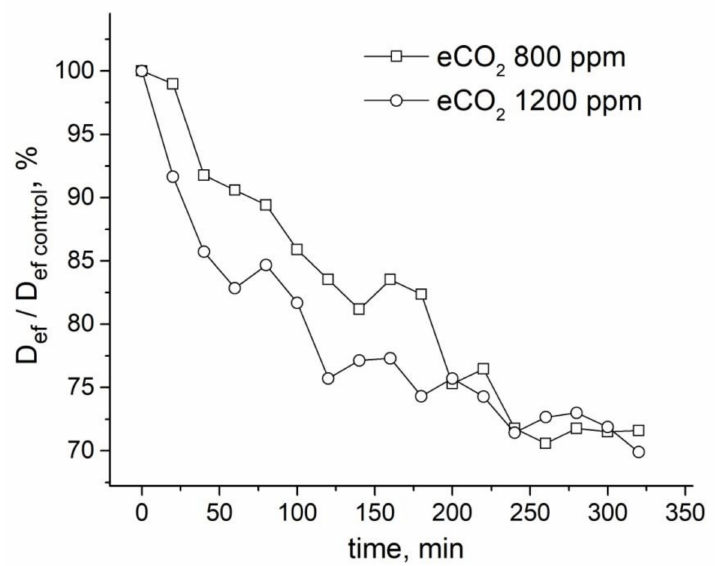
Figure 22. Time dependence of the ratio of effective self-diffusion coefficient ( D ef ) in maize roots under impact of different concentrations of CO 2 to the control value of D ef ( D ef control before CO 2 enrichment): Open squares—dynamics of D ef / D ef control under impact of CO 2 800 ppm; open circles— dynamics of D ef / D ef control under impact of CO 2 1200 ppm [96].